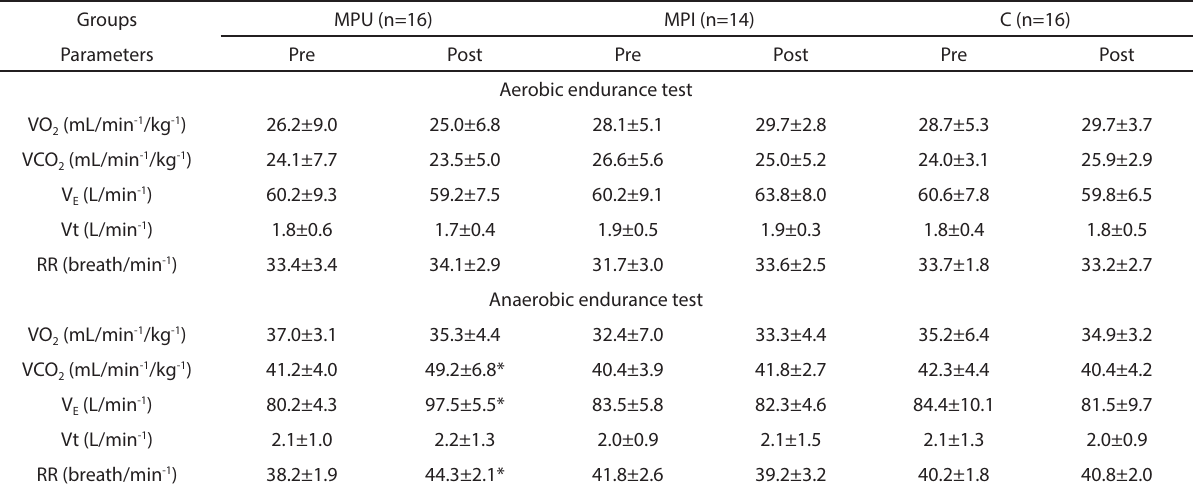
Table 3. Respiratory and metabolic parameters at aerobic and anaerobic endurance tests after three